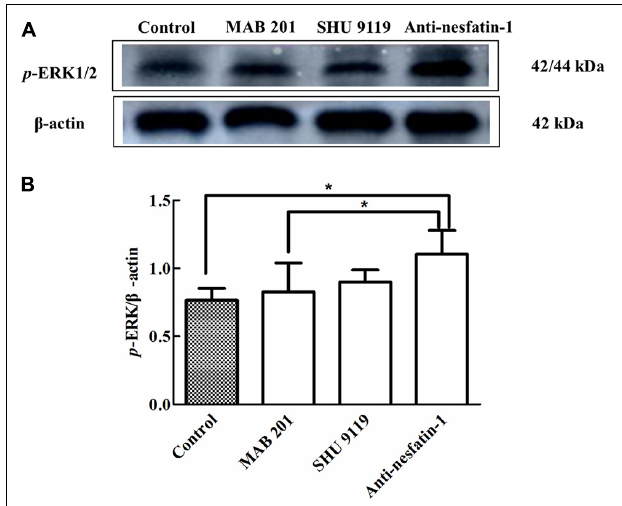
FIGURE 7 | Anti-nesfatin-1 antibody treatment induced an increase in p -ERK protein levels ( n = 6). (A) An original image of a Western blot showing the p -ERK protein levels in control mice and mice treated with MAB 201, SHU 9119 or anti-nesfatin-1 antibody. (B) Statistical analysis of p -ERK protein levels in the different groups. Each value represents the mean ± SD, n = 6; * p < 0.05. MAB 201, non-immune anti-mouse IgG antibody; SHU 9119, MC4R receptor inhibitor; p -ERK, phosphorylated ERK.